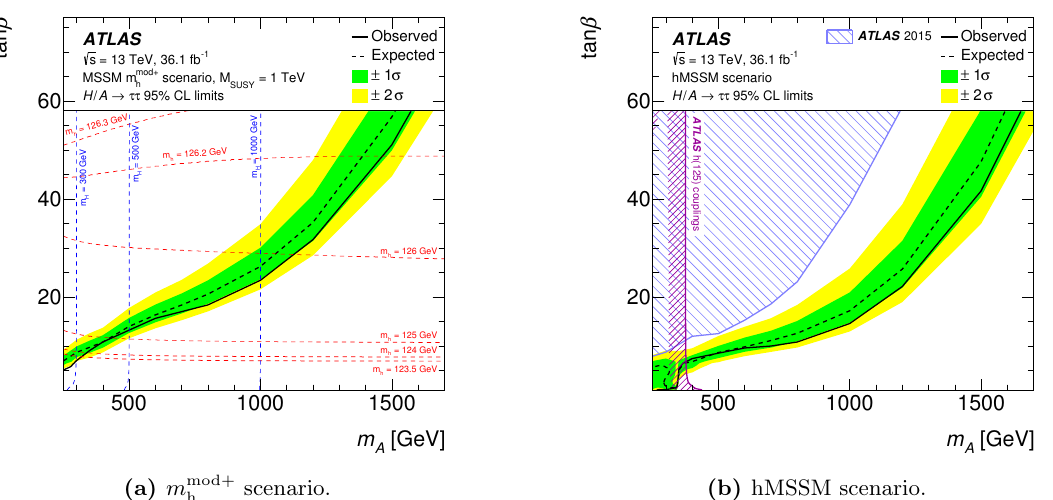
Figure 10. The observed and expected 95% CL upper limits on tan (cid:12) as a function of m A in the MSSM (a) m mod+ and (b) hMSSM scenarios. For the m mod+ h